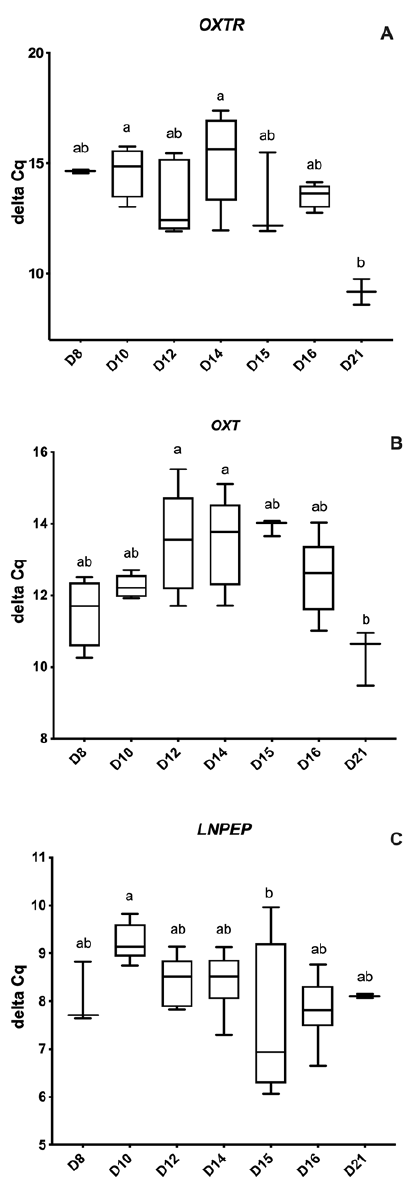
Figure 2. Relative abundance (delta Ct) of oxytocin-related genes by embryonic age (Days 8 to 21 post-ovulation); ( A ) Oxytocin receptor ( OXTR ), ( B ) Oxytocin/neurophysin 1 ( OXT ), and ( C ) Leucine- Cystinyl aminopeptidase ( LNPEP ). Delta Ct concentration has an inverse relationship to mRNA abundance. Differences between days ( p < 0.05) are indicated by different superscripted